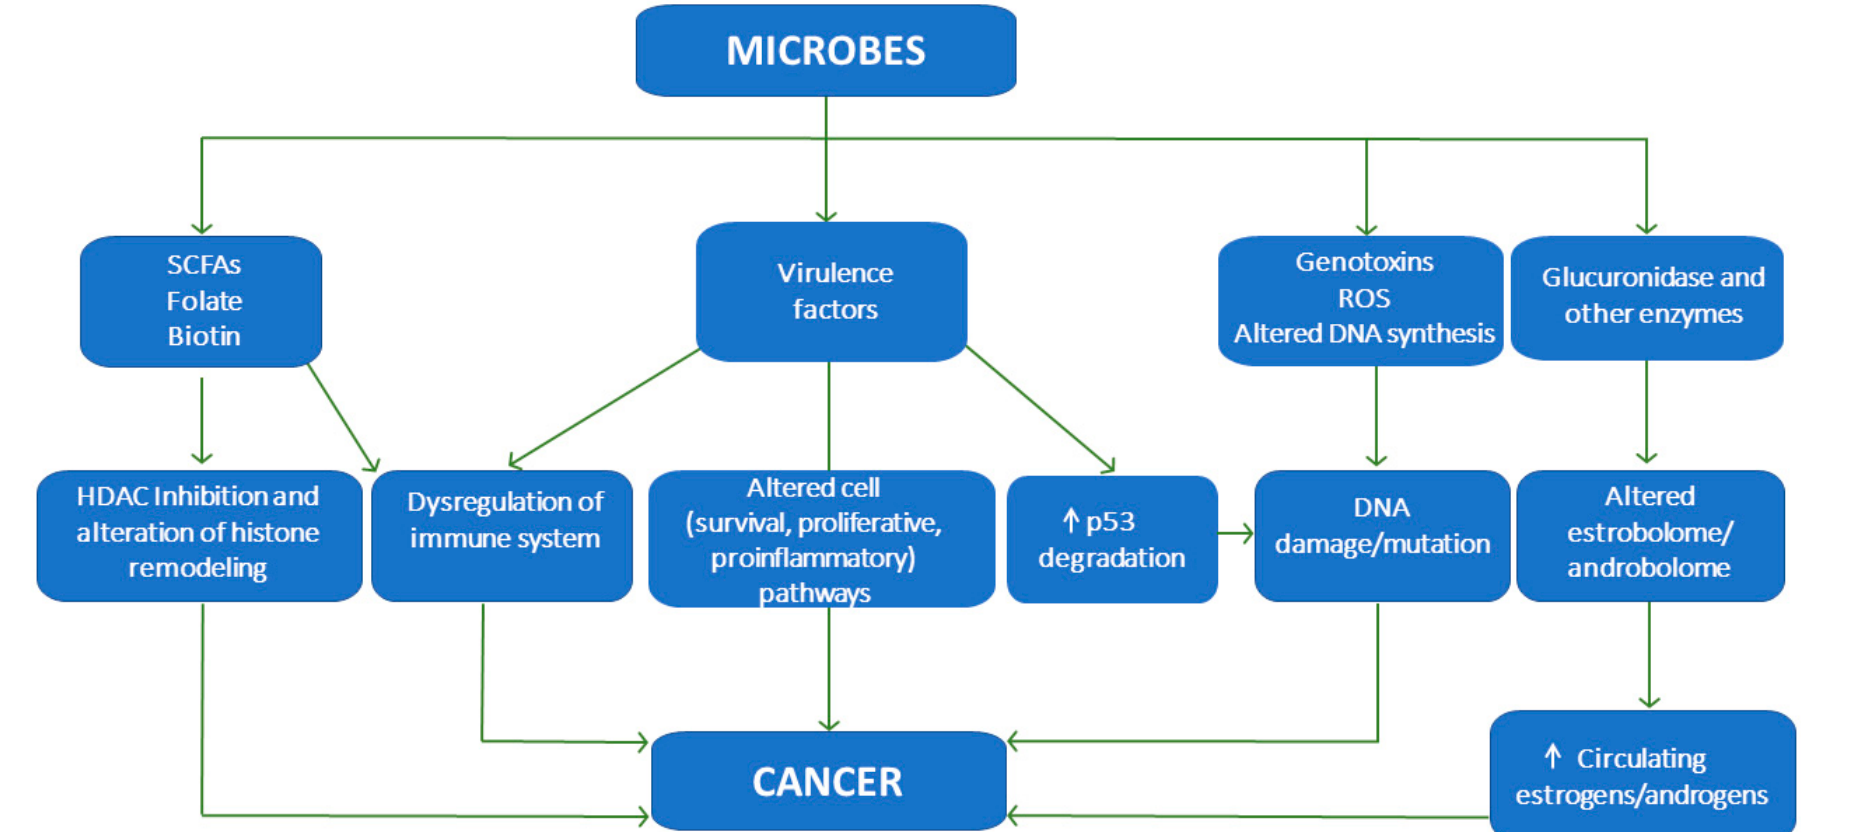
Figure 1. Several proposed mechanisms to understand the microbial influence on cancer. ↑ means increment.